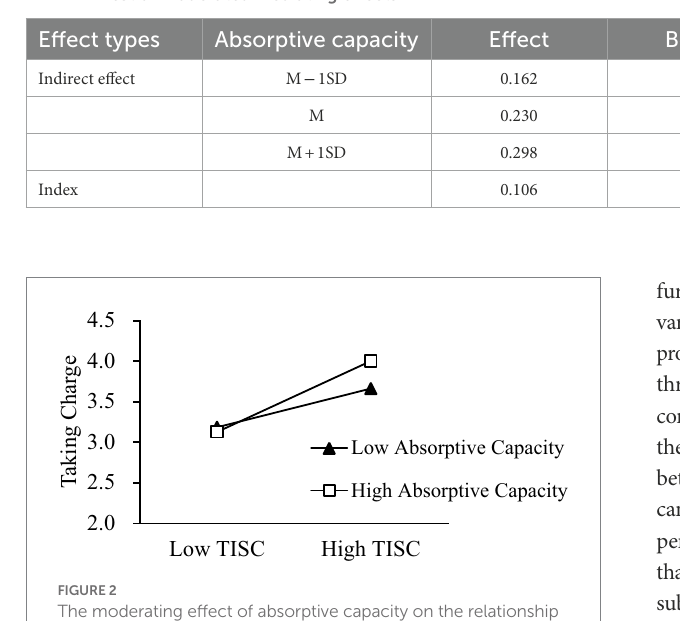
TABLE 4 Test of moderated mediating effects.